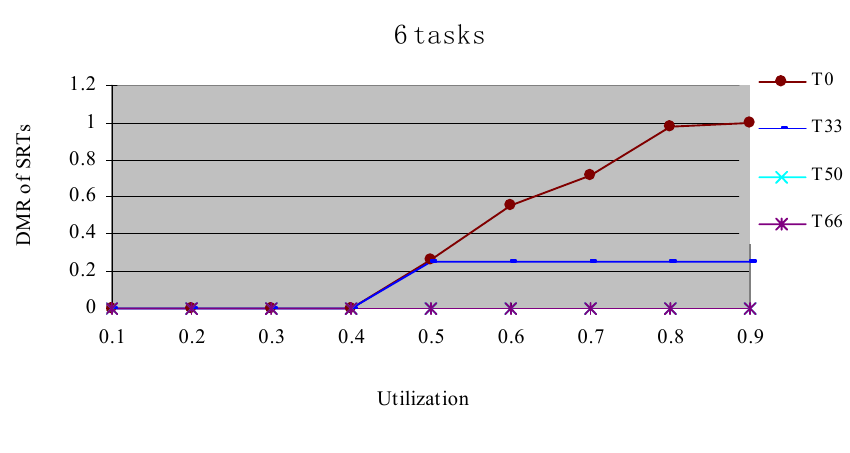
Figure 5. DMR of SRTs at different task type ratio. 6